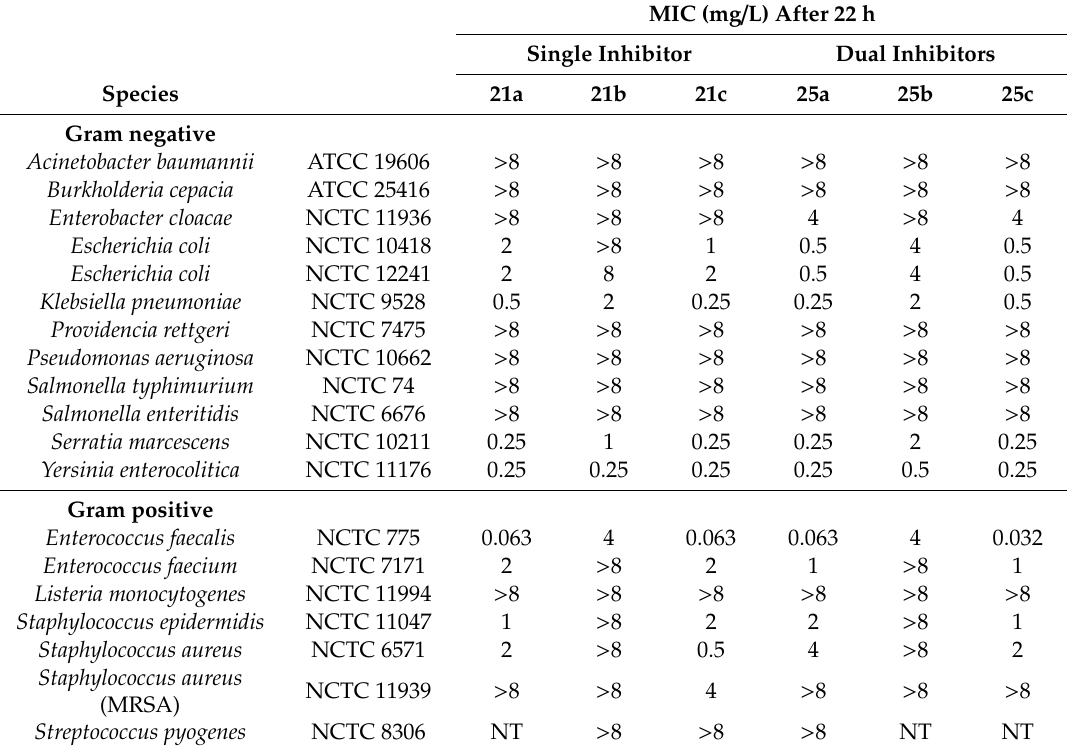
Minimum inhibitory concentration of diastereoisomeric l -Nva- l -Ala- d / l